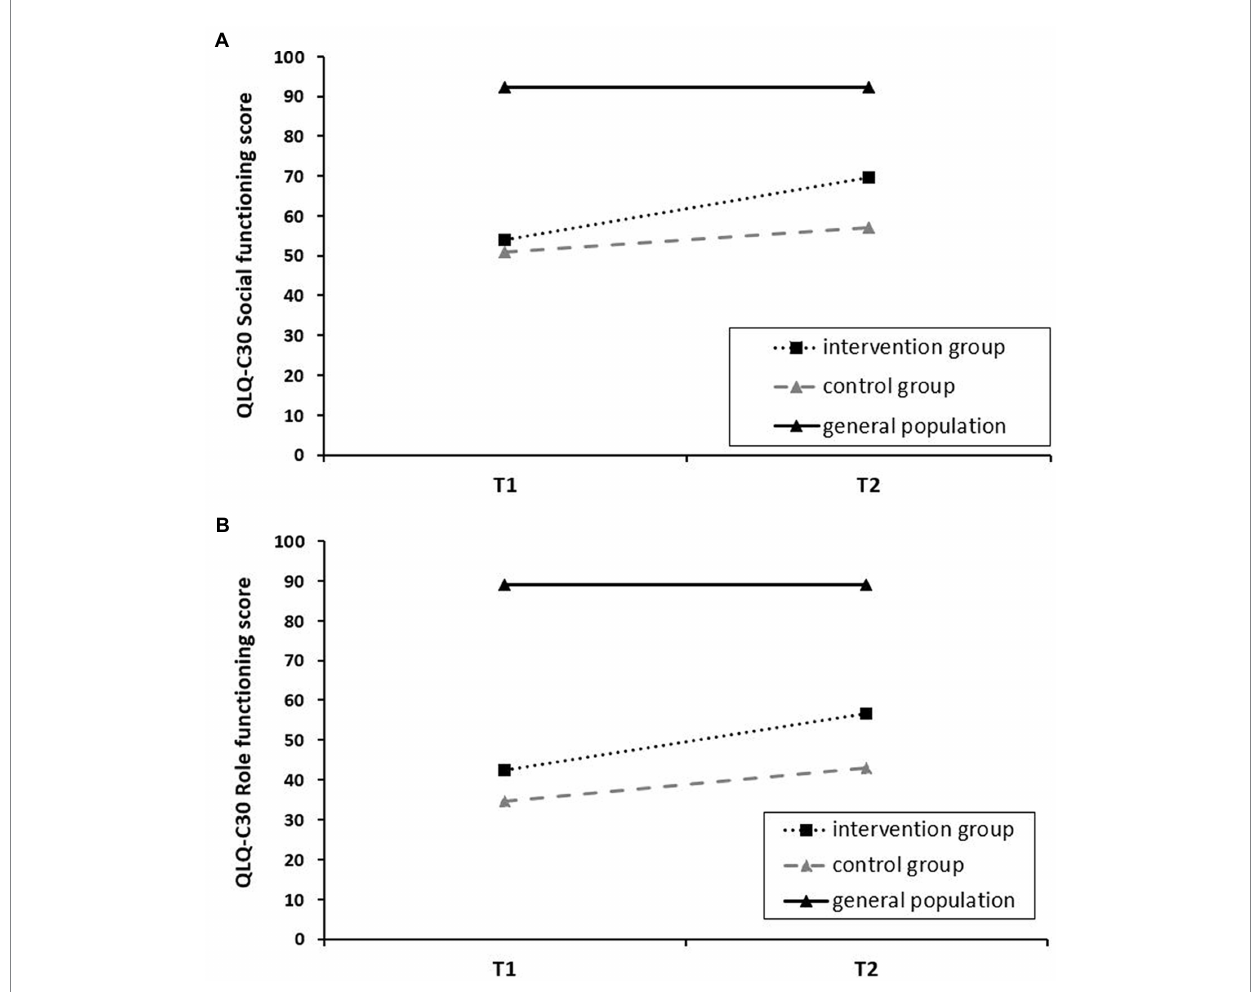
FIGURE 1 Mean scores for social functioning (A) and role functioning (B) at study entry (T1) and the end of the study (T2) for the intervention and control groups, according to the two subscales of the EORTC QLQ-C30. Study data were compared to data from the Austrian general population